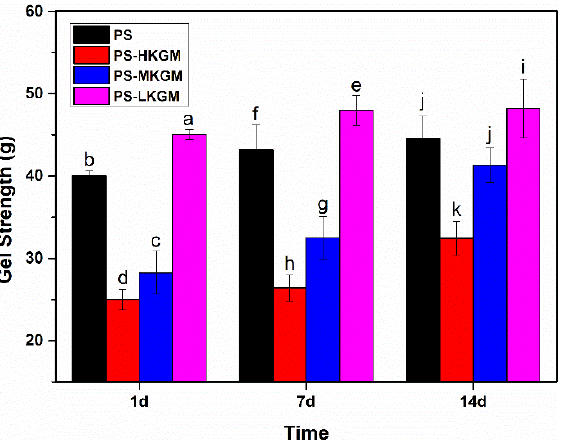
Figure 3. Gel Strength of PS — KGM mixtures at different storage times (HKGM, MKGM and LKGM represent KGM with high, medium and low molecular weight, respectively. PS represents pea starch. Different letters indicate significant differences at the p < 0.05 level).